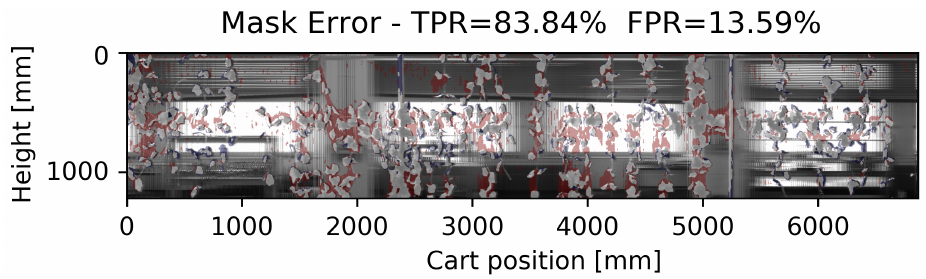
Figure 10. Error of estimated profile of vineyard with RGB-D camera with respect to the ground-truth map: the gray areas represent the correct identification of the profile while the red and blue areas correspond to an overestimation and underestimation of the profile, respectively.